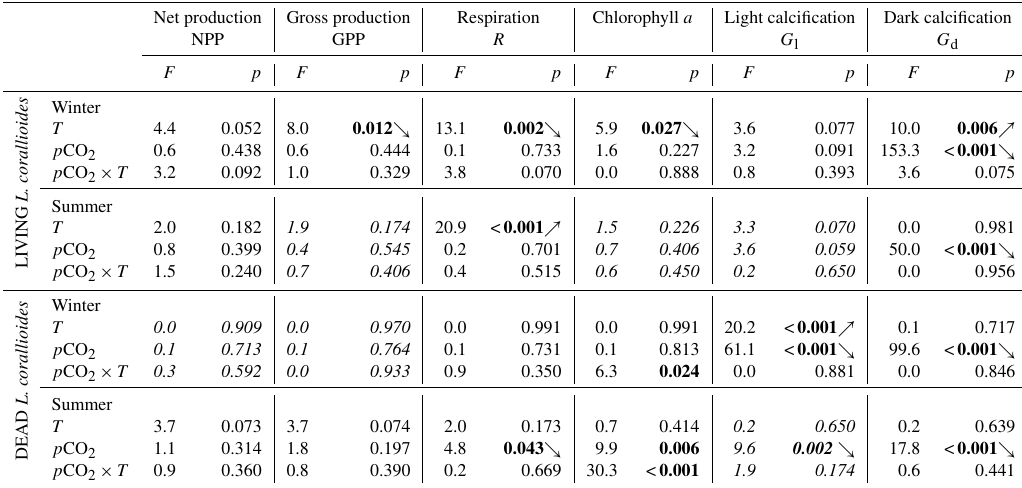
Table 5. Results the analysis of variance for the effects of temperature ( T ) and p CO 2 on net and gross primary production, respiration, chlorophyll a content, and light and dark calcification rates of living and dead Lithothamnion corallioides ( n = 5). Statistical analyses were performed using two-way crossed ANOVAs and Scheirer–Ray–Hare tests when test assumptions were not respected (in italic). Significant p values are shown in bold ( α = 0.05). Degrees of freedom = 1.